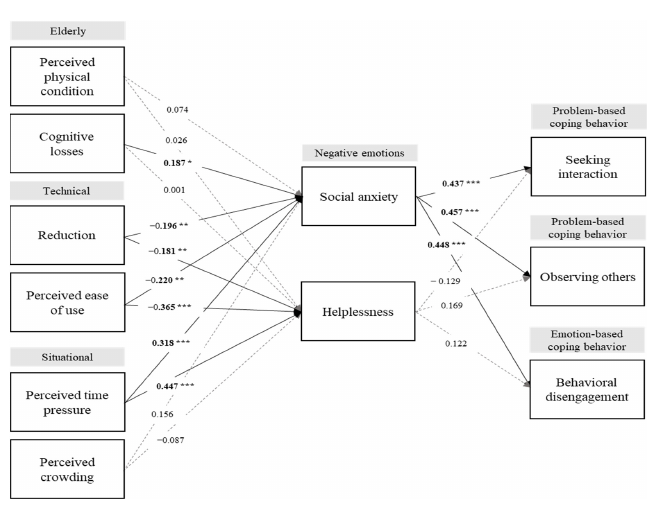
Figure 2. Research model test results; * p < 0.05, ** p < 0.01, *** p < 0.001.